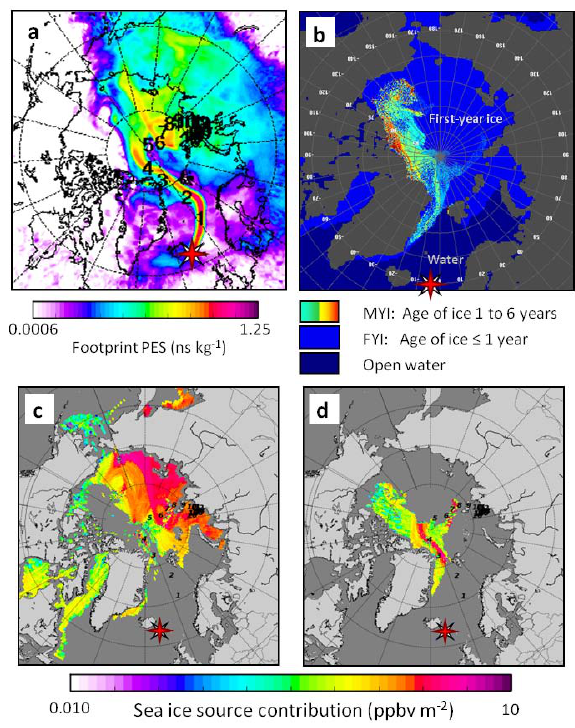
Fig. 4. (a) Circumpolar map of the FLEXPART modeled footprint potential emission sensitivity (PES) for the air mass sampled on 2 April 2008 at 00:00UTC. The bold numbers represent the days of transport backward in time. (b) Map of the Arctic sea ice coverage colored by the modeled sea ice age for 1–7 April 2008. FLEXPART sea ice source contribution maps for (c) FYI and (d) MYI. The red star in panels (a–d) indicates the position of the R/V Knorr (62.9 ◦ N, 12.3 ◦